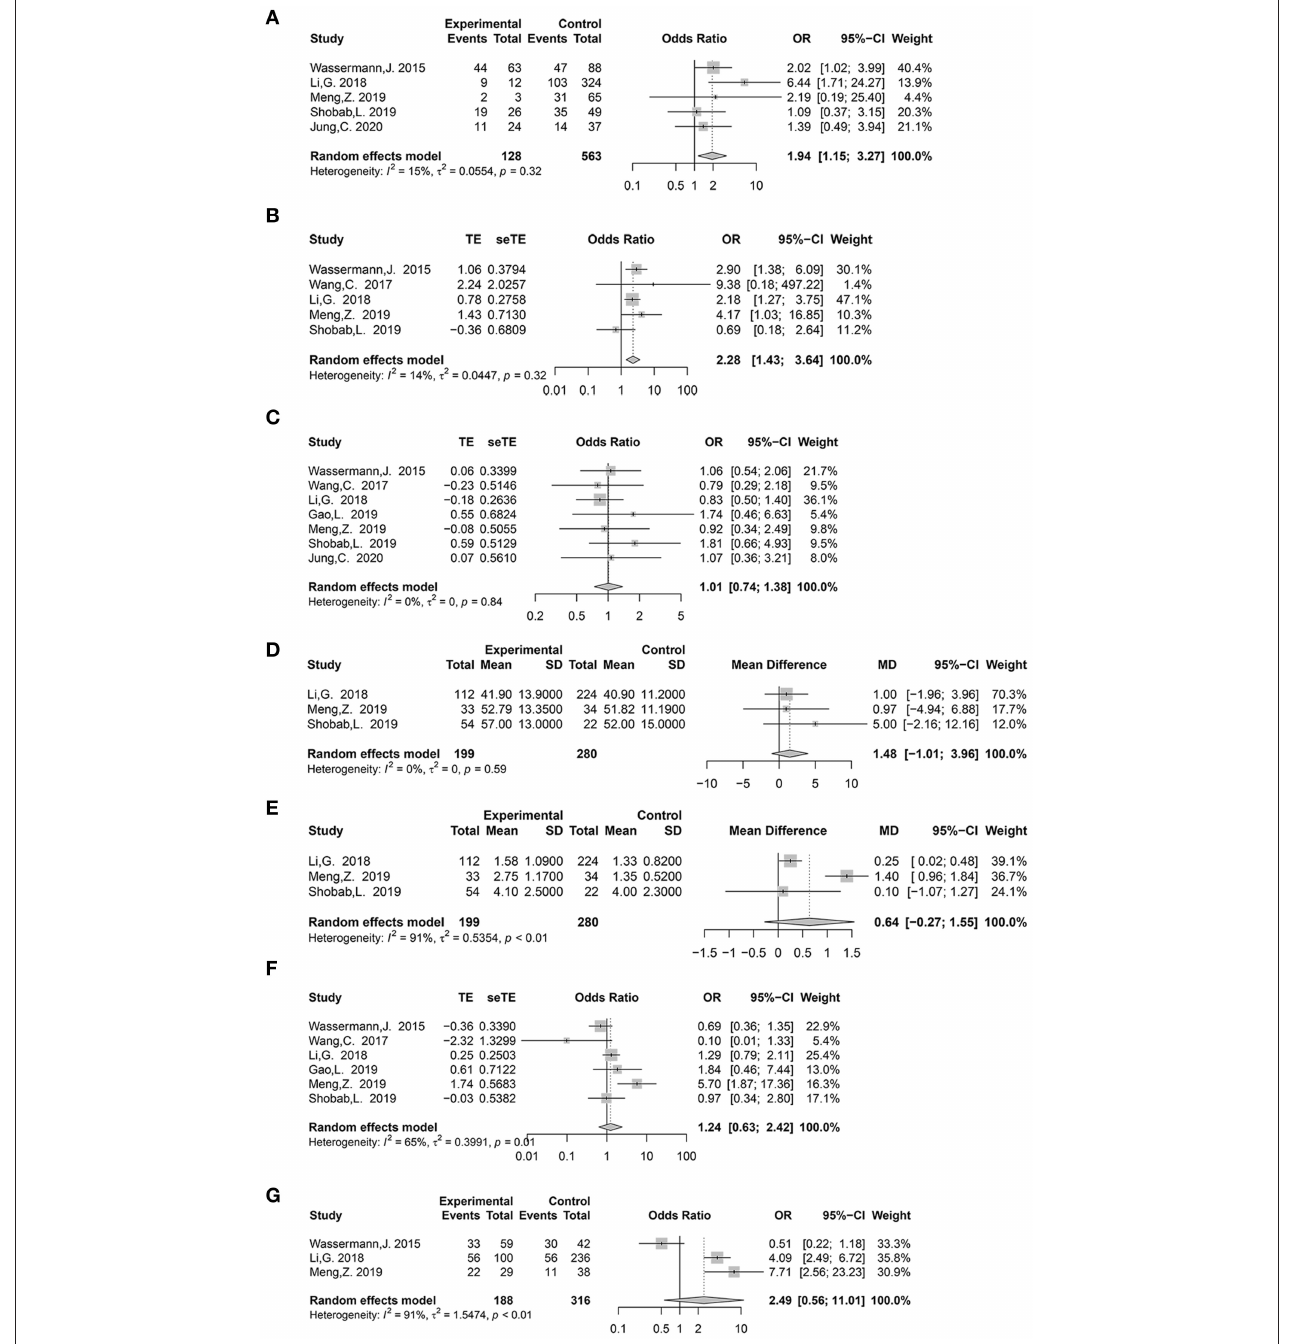
FIGURE 2 | Forest plot detailing odds ratio and mean difference with 95% confidence intervals (CI) for the effect of histological subtype (A) , extrathyroidal extension (B) , gender (C) , age (years) (D) , tumor size (cm) (E) , multifocality (F) , and lateral lymph node metastasis (G)